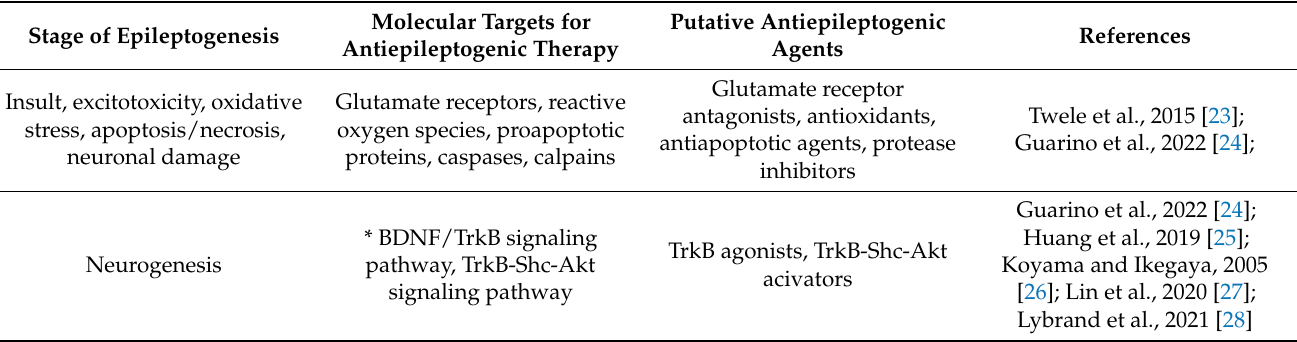
Table 2. Possible molecular targets for antiepileptogenic